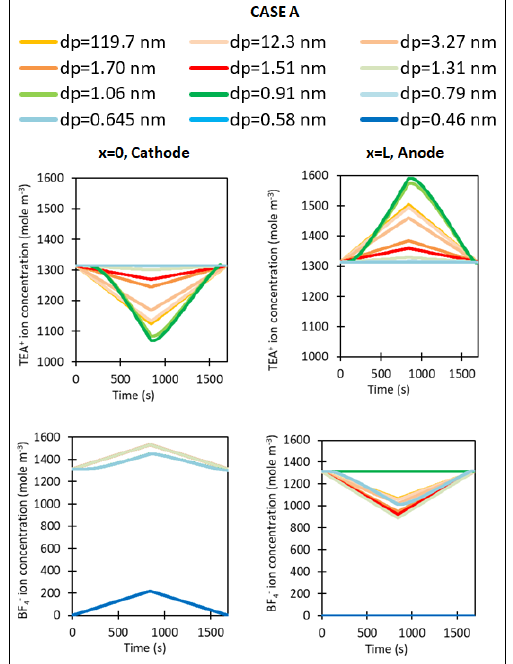
Figure 6. Predicted ion concentration profiles against time at x = 0 (cathode/current collector) and x = L (anode/current collector) for Case A: ACF fabric electrodes and 1.5 M TEABF 4 /AN